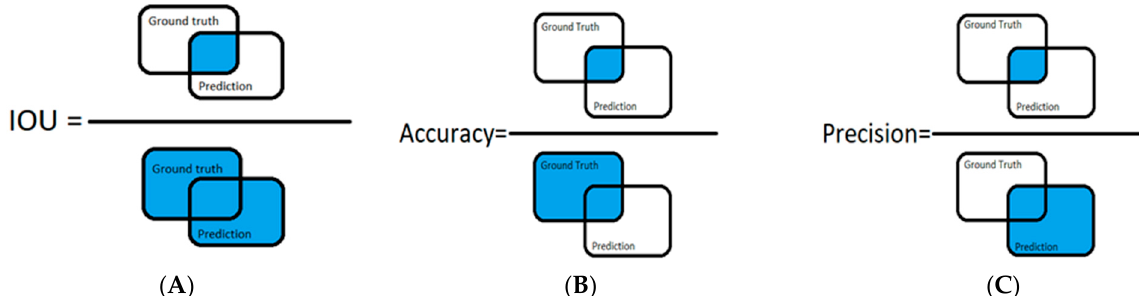
Figure 4. IoU ( A ), Accuracy ( B ), and Precision Representation ( C ).